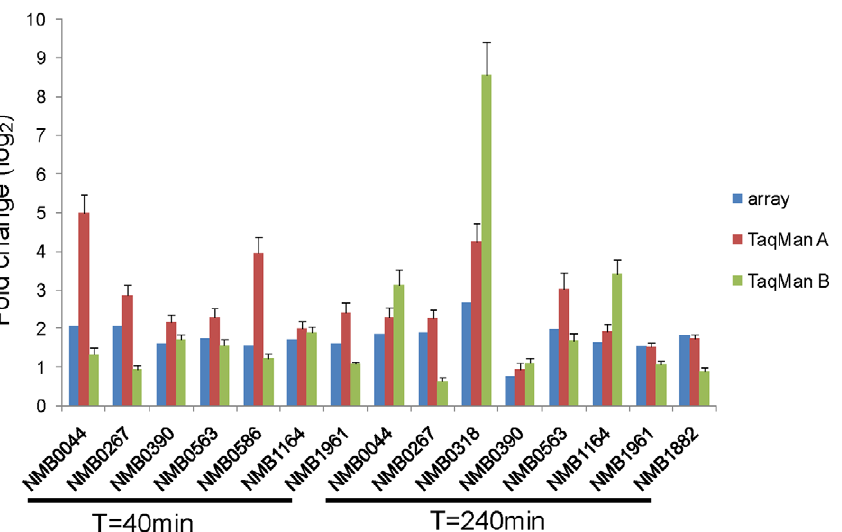
Figure 5. Meningococcal purine and pyrimidine biosynthesis pathway deduced from KEGG pathway database [ 49 ] . Genes found to be up-regulated are indicated (up). * indicates that PurB catalyzes conversion of SAICAR to IMP and IMP to AMP.